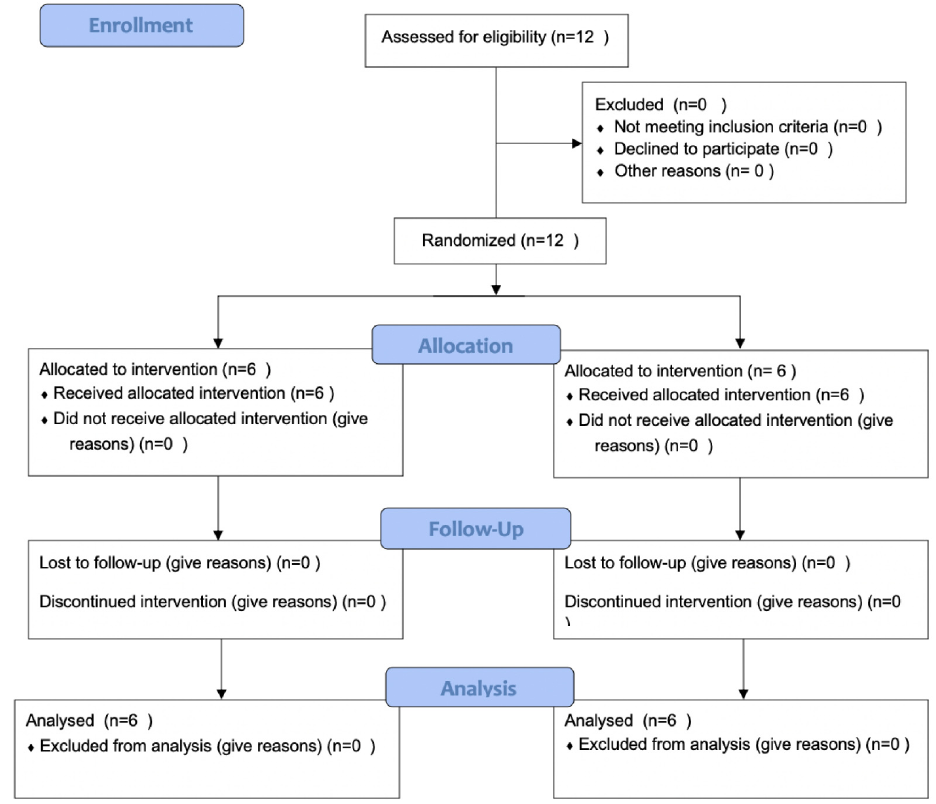
Figure 2. Study flow